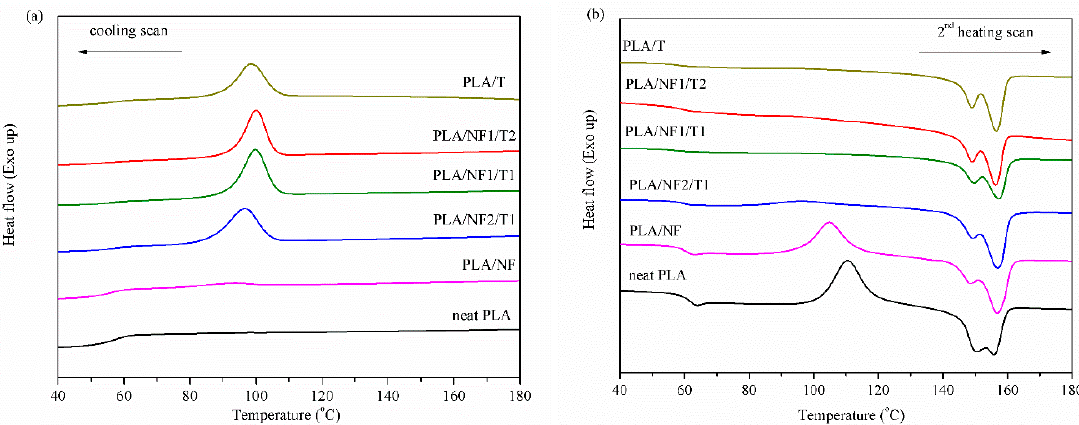
Figure 6. DSC thermograms of PLA hybrid composites at different filler ratios: ( a ) cooling scan and ( b ) second heating scan.